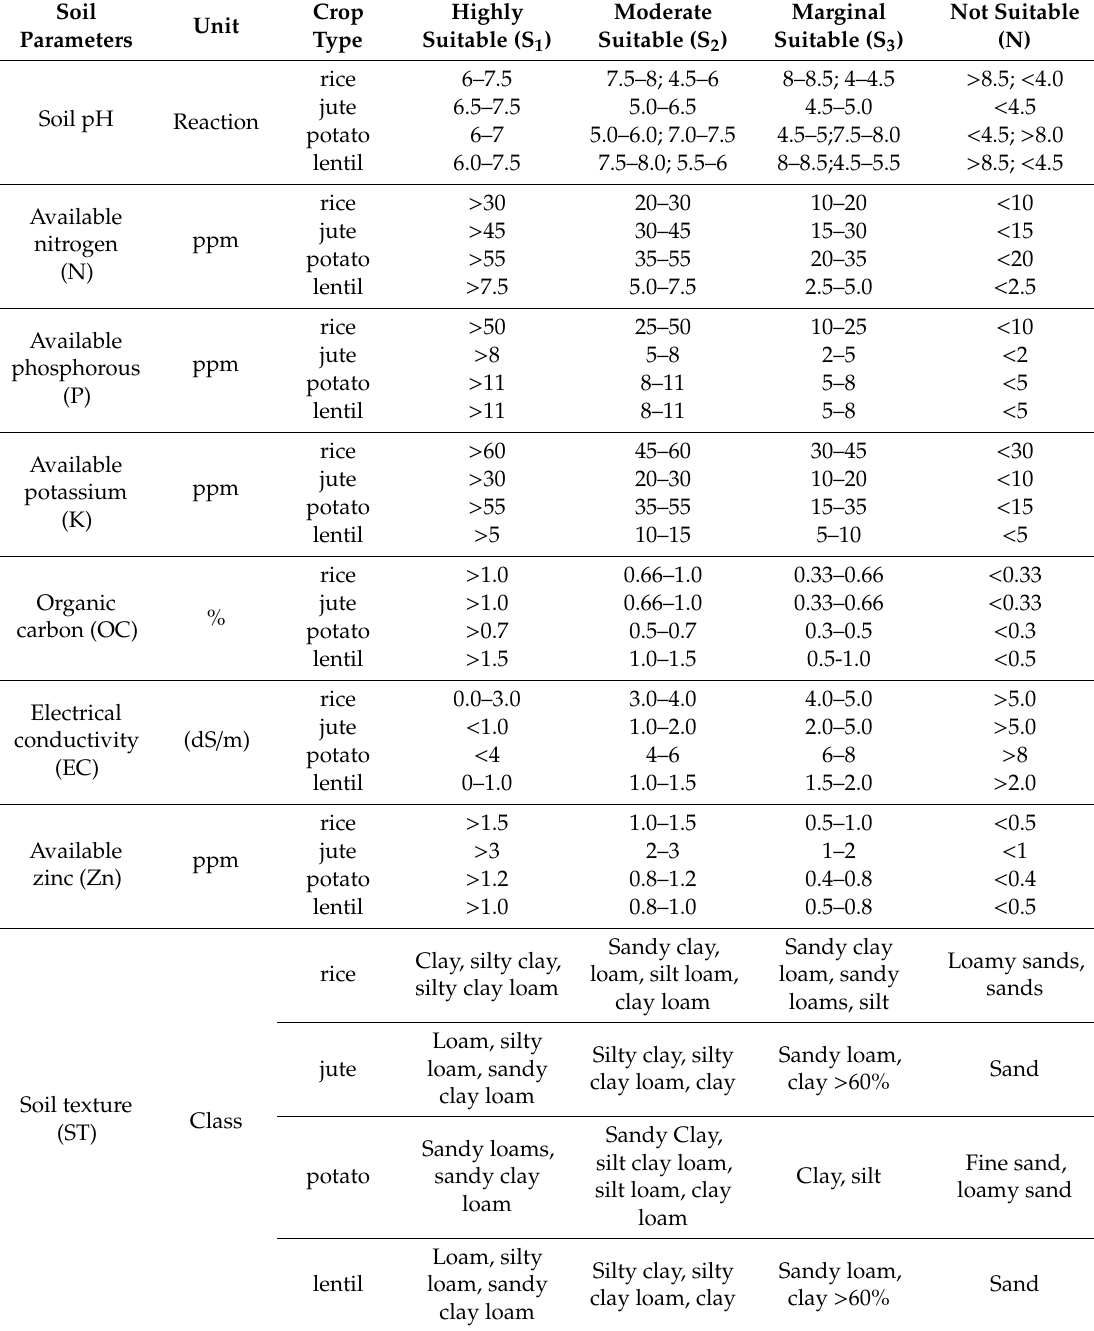
Table 1. Suitability range for individual soil parameters for the crops.